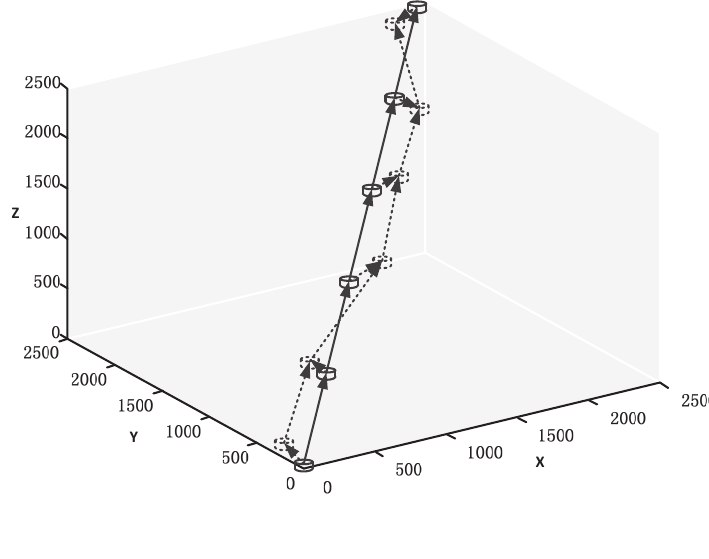
Figure 4. An example of six-node